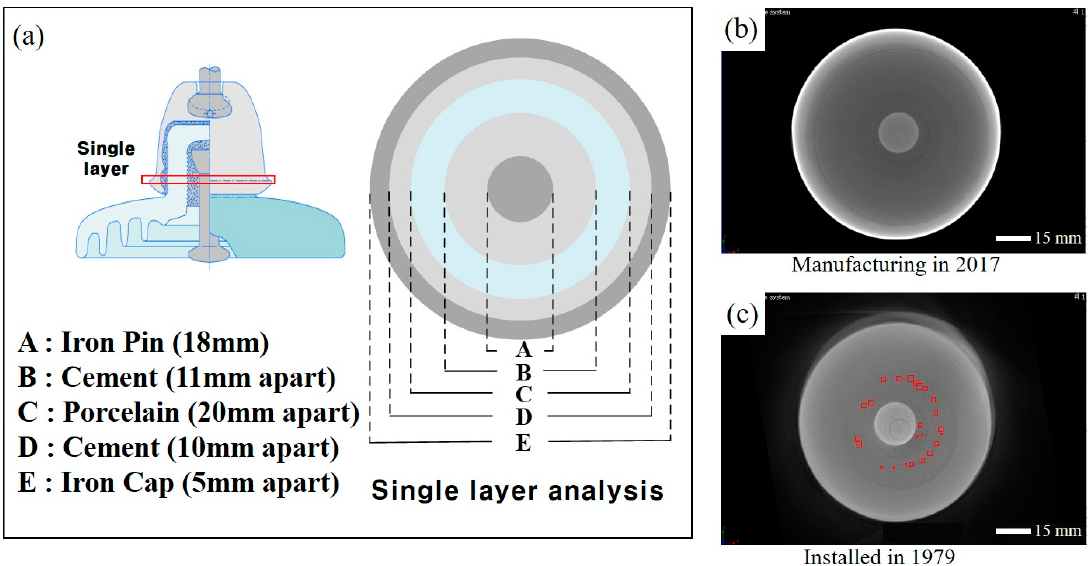
Figure 2. Cross-sectional composition and three-dimensional computed tomography (3D-CT) analysis photo of new and aged of porcelain insulator. ( a ) Cross sectional analysis; ( b ) 3D-CT of new porcelain insulator; ( c ) 3D-CT of aged porcelain insulators.